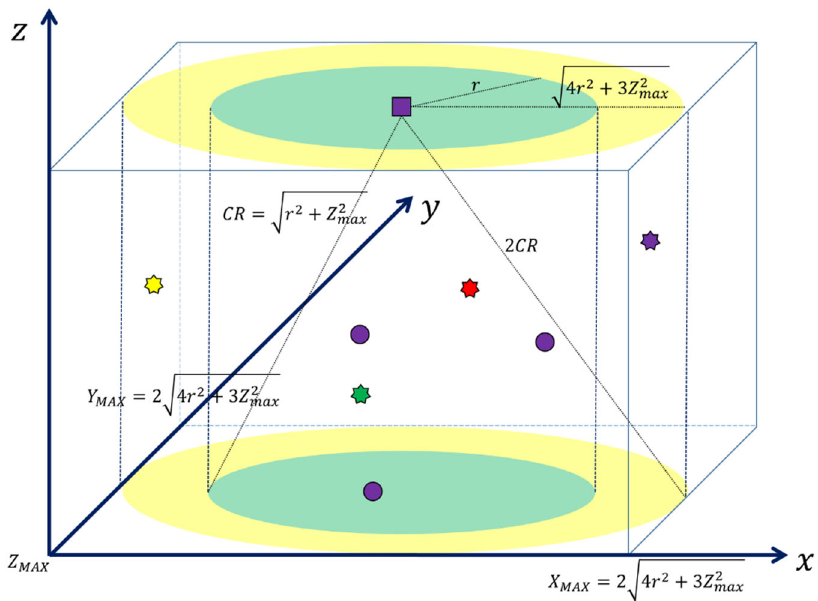
Figure 4. A topology of a UCAN illustrating the location of CUs and NCUs and the communication and sensing ranges.